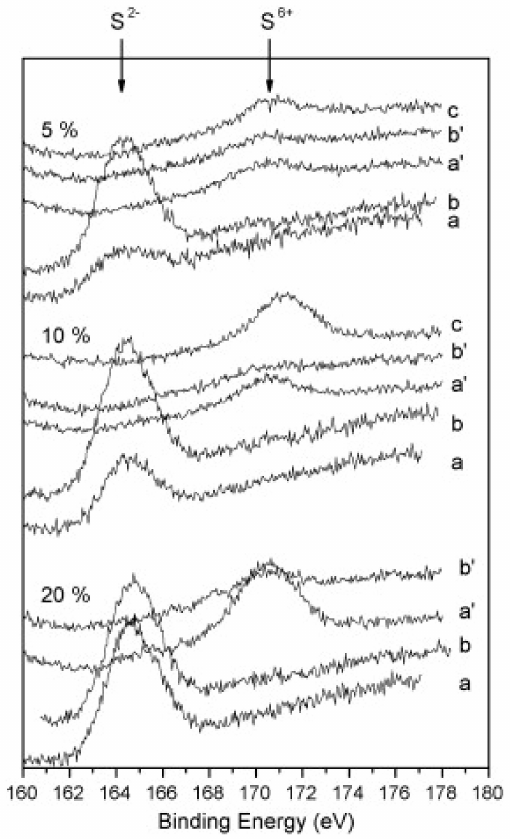
Figure 19. S2p XPS region modified silica; co-condensed samples: a reduced, a (cid:48) oxidized; grafting samples: b reduced, b (cid:48) oxidized; in situ oxidized samples: c from ref [97]. Reprinted with permission from ref. [97]. Copyright 2010